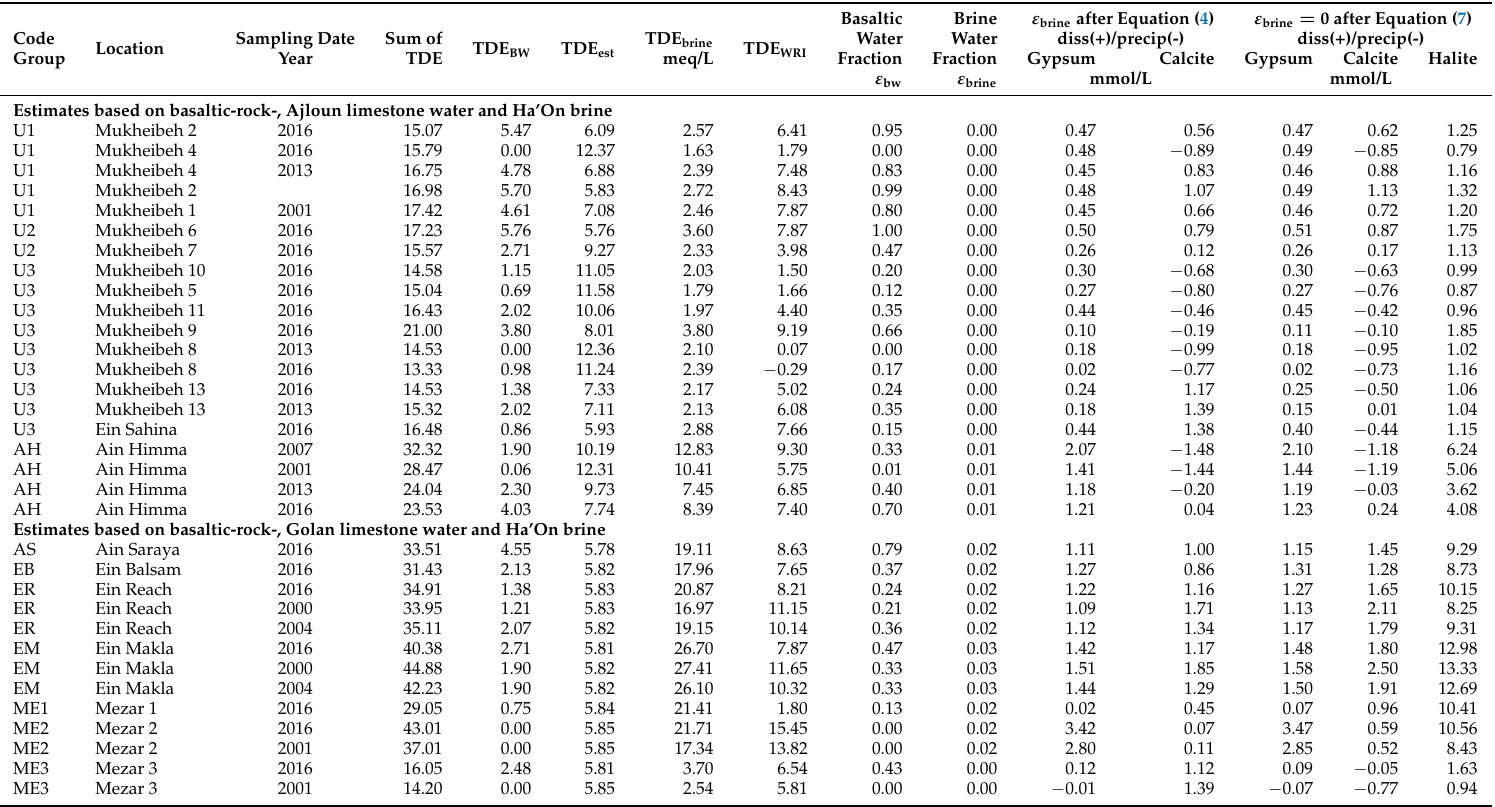
Table 3. Compilation of TDE values; brine fraction ε brine ; and mineralogical compositions of water/rock interaction (WRI) and WRI+brine.